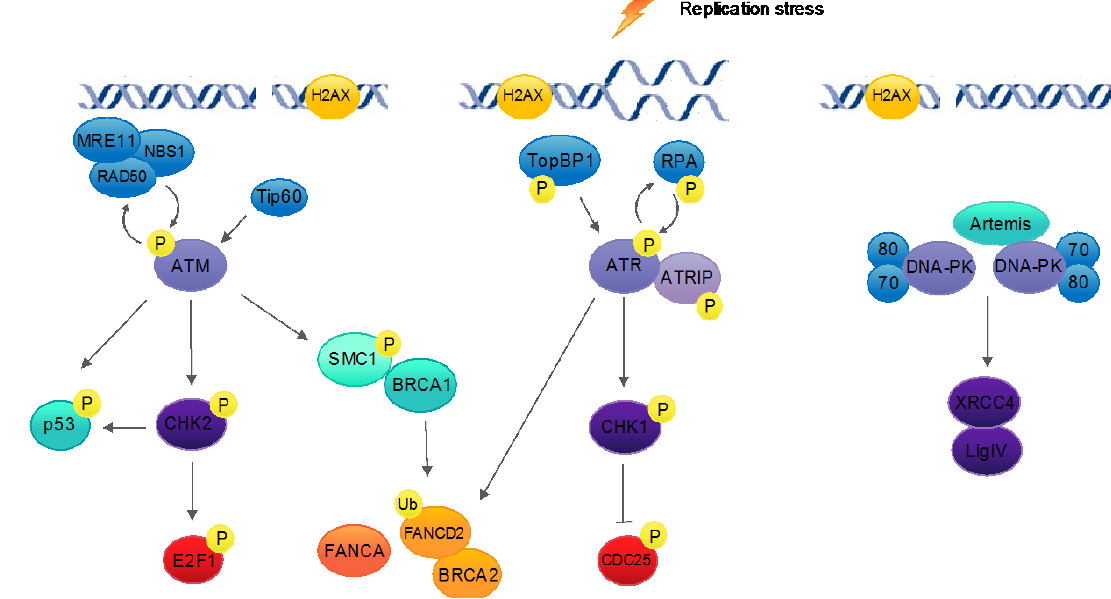
Figure 3. Host DNA damage response pathways. The ataxia telangiectasia-mutated (ATM) and ATM and Rad3-related (ATR) pathways are activated in response to damaged DNA signals, leading to cell cycle checkpoint arrest, DNA repair or apoptosis. ATM is activated by DNA double-strand breaks and initiates downstream response pathways through the phosphorylation of effector proteins, including CHK2 and DNA repair proteins BRCA1 and pSMC1. In addition to the repair of double-strand breaks, ATM is involved in G1/S, intra-S and G2/M cell cycle checkpoint controls, in part through its phosphorylation of p53. ATR responds to replication stress in the form of bulky lesions and the presence of single-stranded DNA at stalled replication forks. It also signals through the activation of specific effector proteins, such as CHK1 and components of the Fanconi Anemia (FA) pathway. The ATM and ATR pathways facilitate DNA repair through the high-fidelity homologous recombination (HR) pathway. DNA double-strand breaks may also be repaired by the DNA- dependent protein kinase (DNA-PK), which coordinates repair through the non-homologous end joining (NHEJ) pathway.